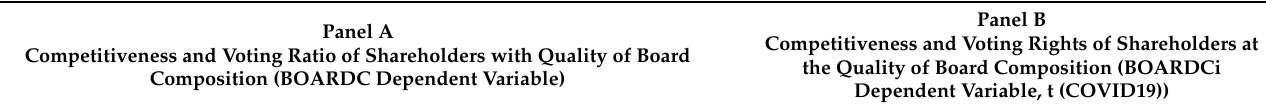
Table 6. The influence of competitiveness and the ratio of voting rights of major shareholders on the quality of companies’ board of directors.